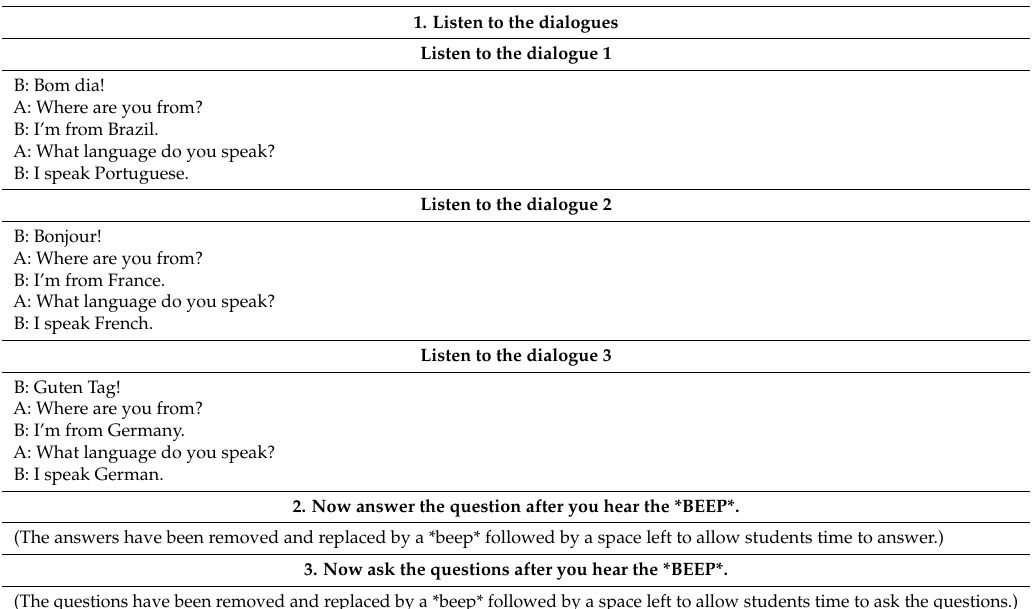
Table 1. Transcript 1: Social Practice 1.